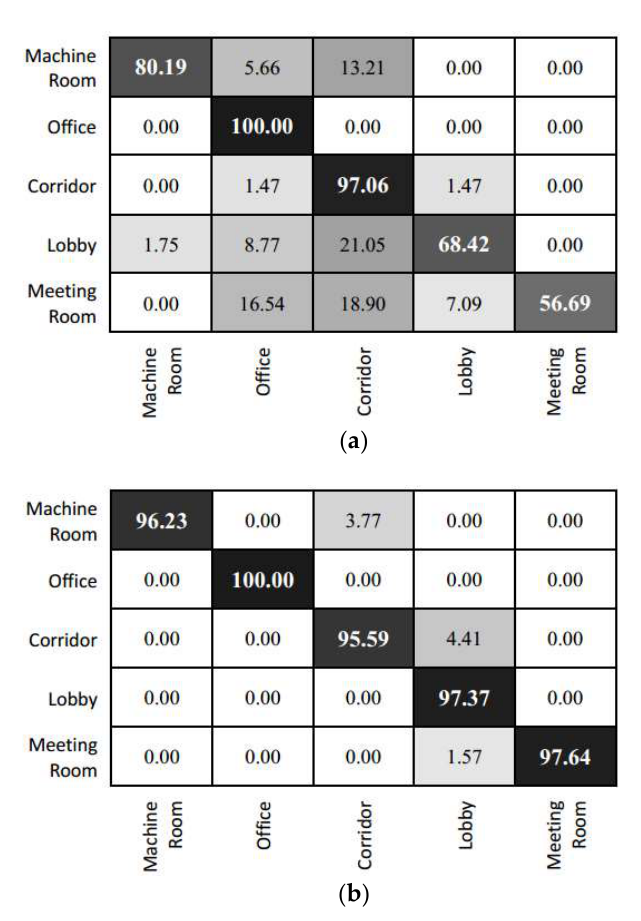
Figure 11. Confusion matrix of the prediction result for the laboratory scene. ( a ) Inception V3; ( b ) the feature fusion model.